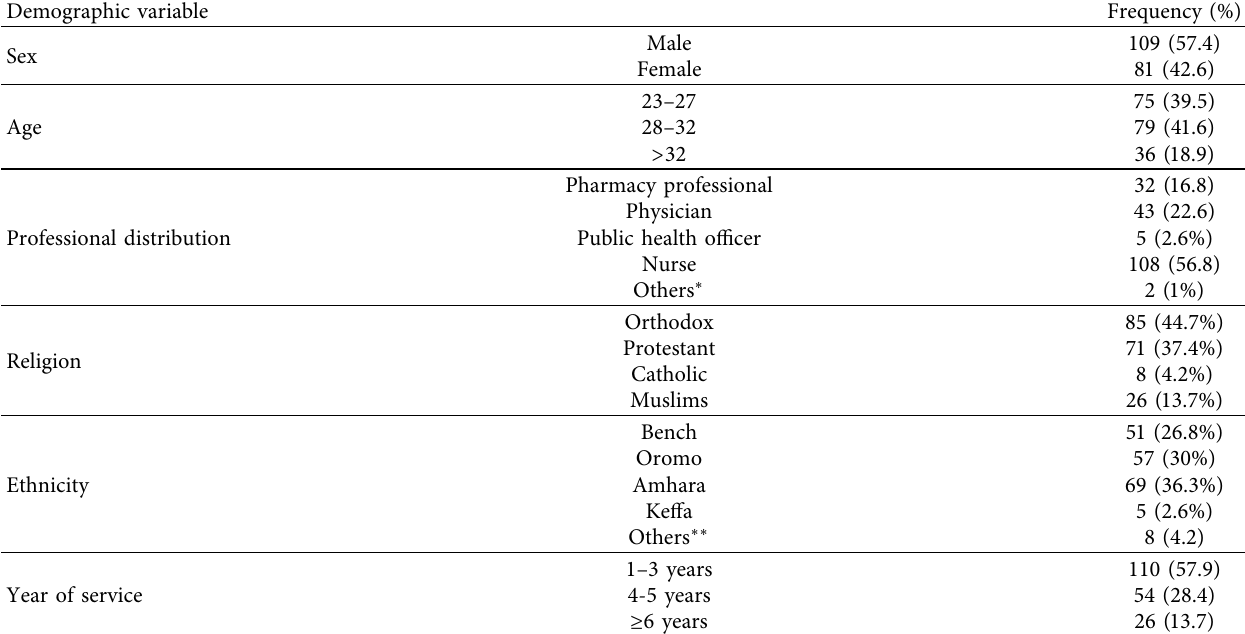
Table 1: Sociodemographic profle of the healthcare providers’ who participated in the study in Mizan Tepi University Teaching Hospital from August to September